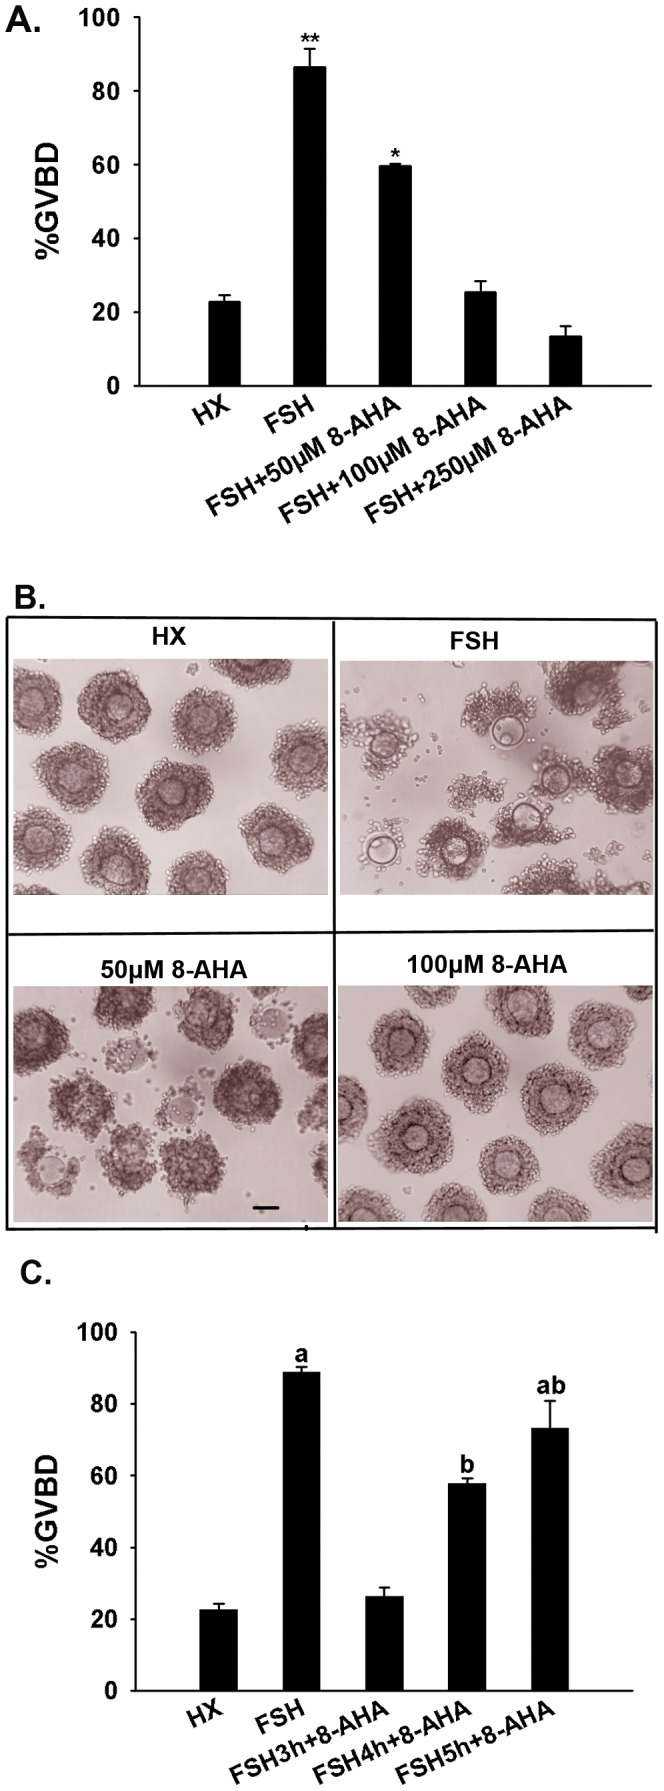
Effect of PKAI on the FSH-induced resumption of meiosis in COC.(A) The PKAI activator 8-AHA-cAMP (8-AHA) dose-dependently inhibited the FSH-induced resumption of meiosis in COC. (B) Cumulus expansion. Cumulus expansion was detected at the end of 22 h culture. HX, control; FSH, 50 IU/L FSH; 50 µM 8-AHA-cAMP; 100 µM 8-AHA-cAMP. Scale bar, approximately 50 µm. (C) The crucial period for the effect of PKAI on FSH stimulation. When 8-AHA-cAMP was added to cultures 3 or 4 h after the start of culture, meiotic induction was significantly reduced. Administration of 8-AHA-cAMP 5 h after the start of culture did not inhibit the induction of meiosis. Columns with different superscripts are significantly different (P<0.05).